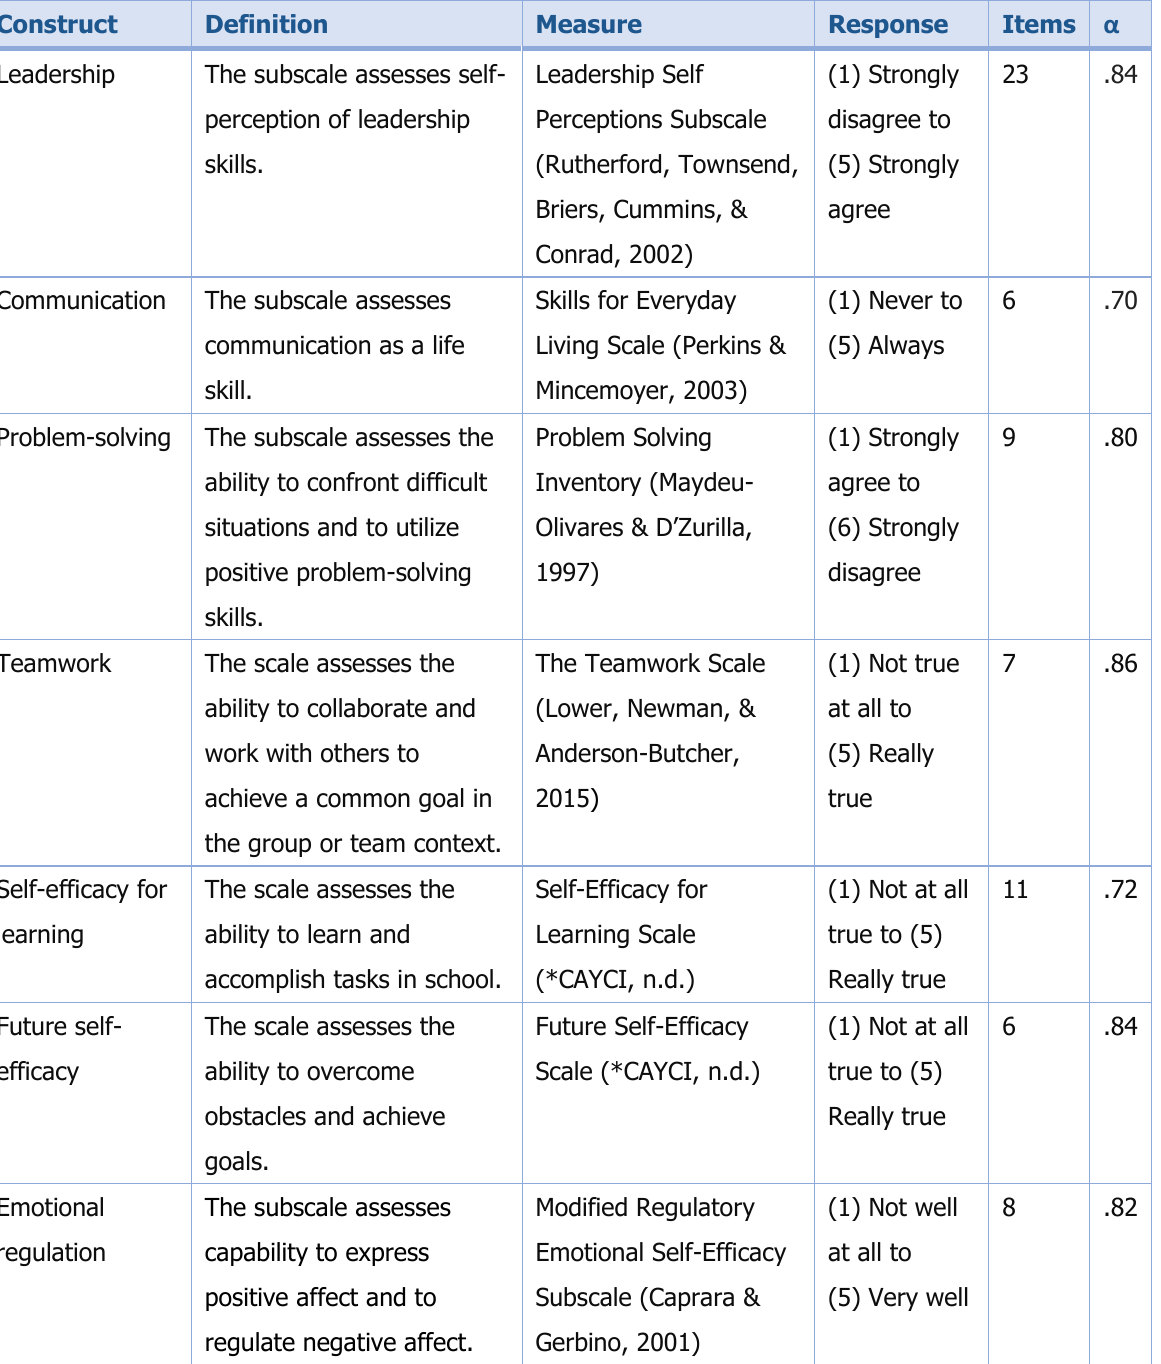
Table 2. Youth Outcome